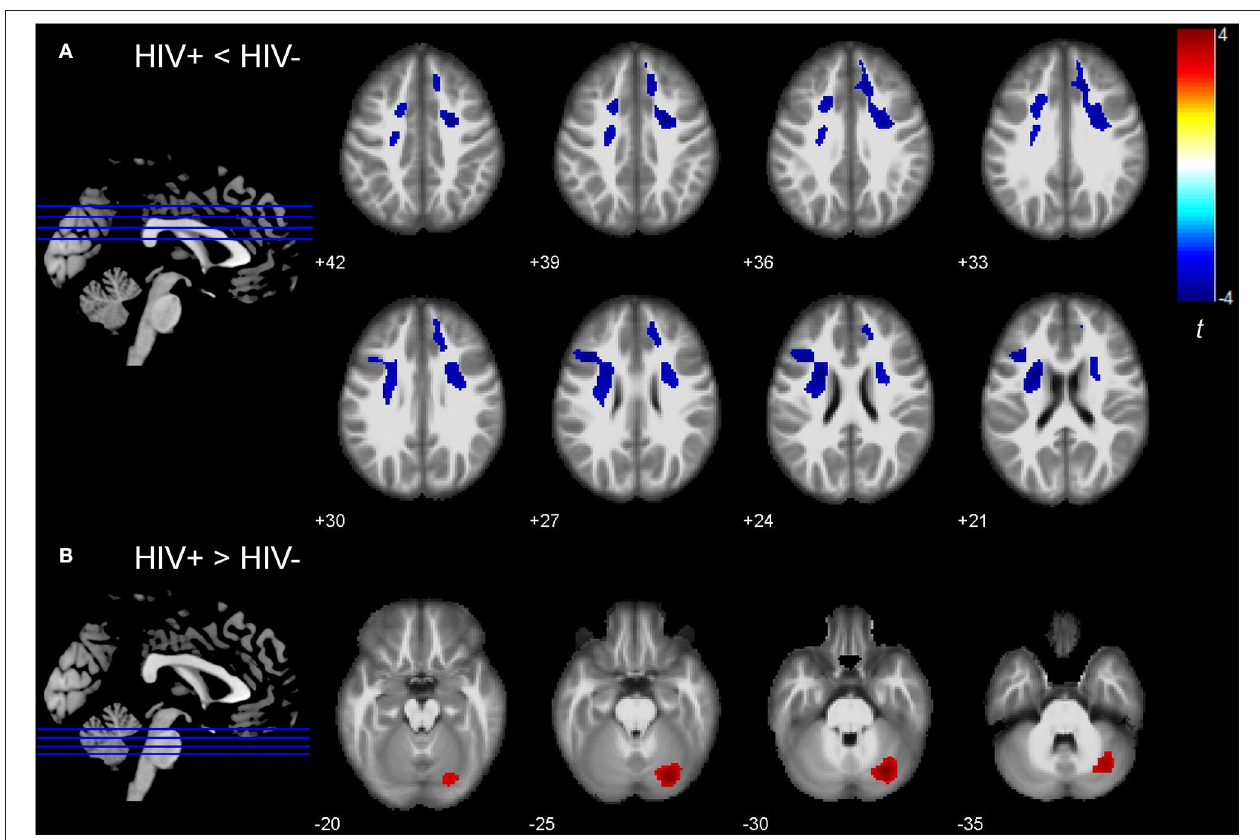
FIGURE 1 | Group differences in deformation-based morphometry (DBM) indexes between HIV infected (HIV + ) and HIV uninfected (HIV-) group. (A) Bilateral superior and left middle frontal regions showed decreased DBM indexes (i.e., tissue atrophy) in the HIV + group (voxel-level uncorrected P < 0.001, cluster level P < 0.05, FWE corrected). (B) Right cerebellum showed increased DBM indexes (i.e., tissue enlargement) in the HIV + group (voxel-level uncorrected P < 0.001, cluster level P < 0.05, FWE corrected). The colors indicate the t -statistics.